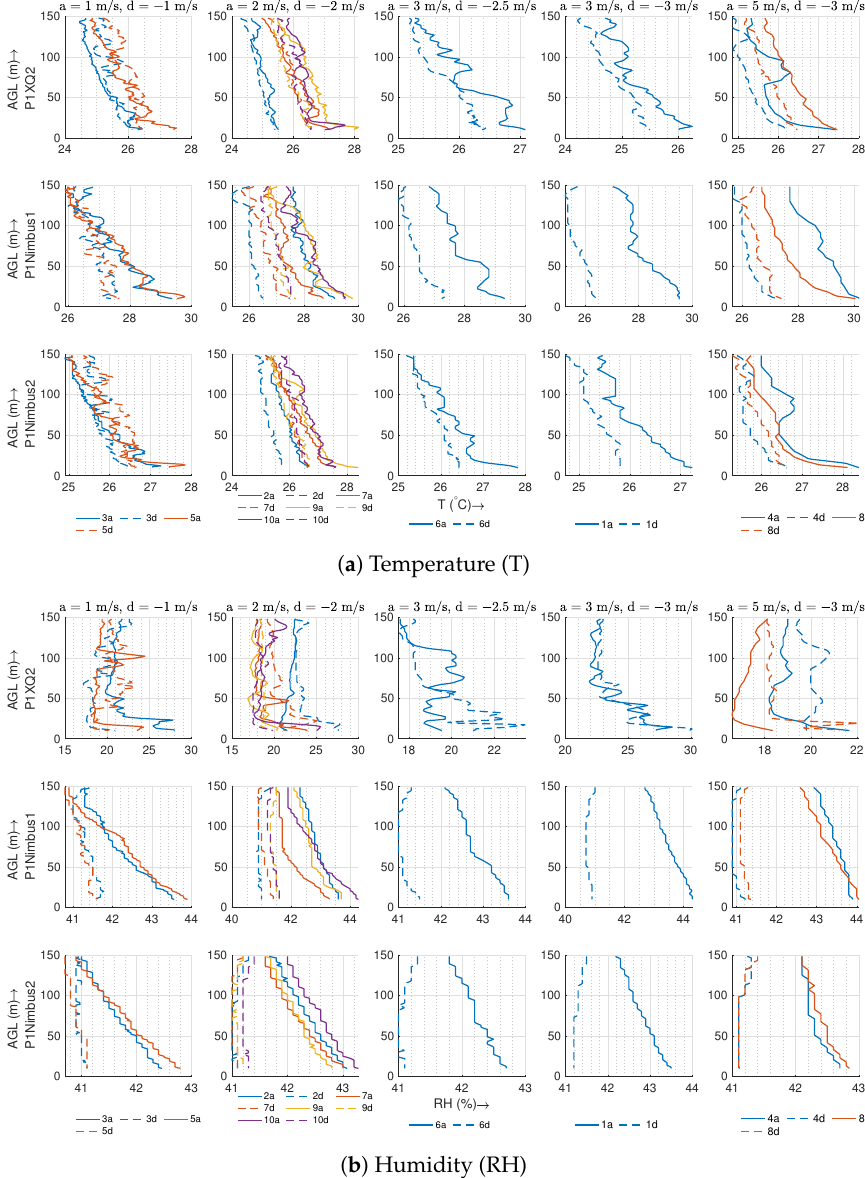
Figure 9. The plot shows the ascent ( a ) and descent ( b ) temperatures against the altitude for 10 consecutive flights conducted over a period of 60 min (7/18/2018 7:21 pm UTC–8:20 pm UTC) at different “a” and “d” speeds mentioned in the title of each subplot. Multiple flights at the same speed are grouped together. The colored legend under the plot indicates the order in which the flight was performed. The sky was slightly cloudy with cumulonimbus clouds, and the ground wind was 4–5 m/s from the NW. The data presented in this plot is not filtered or corrected for sensor response